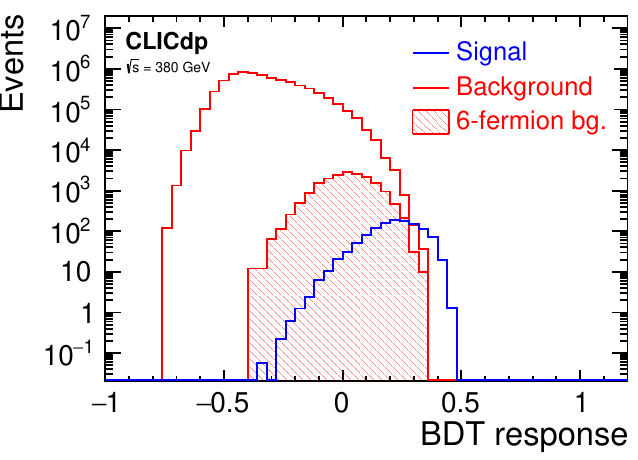
Figure 27. Distribution of the BDT classi(cid:12)er response for events with FCNC top-quark decay t ! c g (signal, blue histogram) and SM events (background, red histogram), for FCNC selec- tion at 380 GeV CLIC. The background sample is normalised to 1.0 ab (cid:0) 1 while the signal (events with FCNC decay) is normalised to BR(t ! c g ) = 10 (cid:0) 3 . The hatched histogram indicates the contribution from the six-fermion